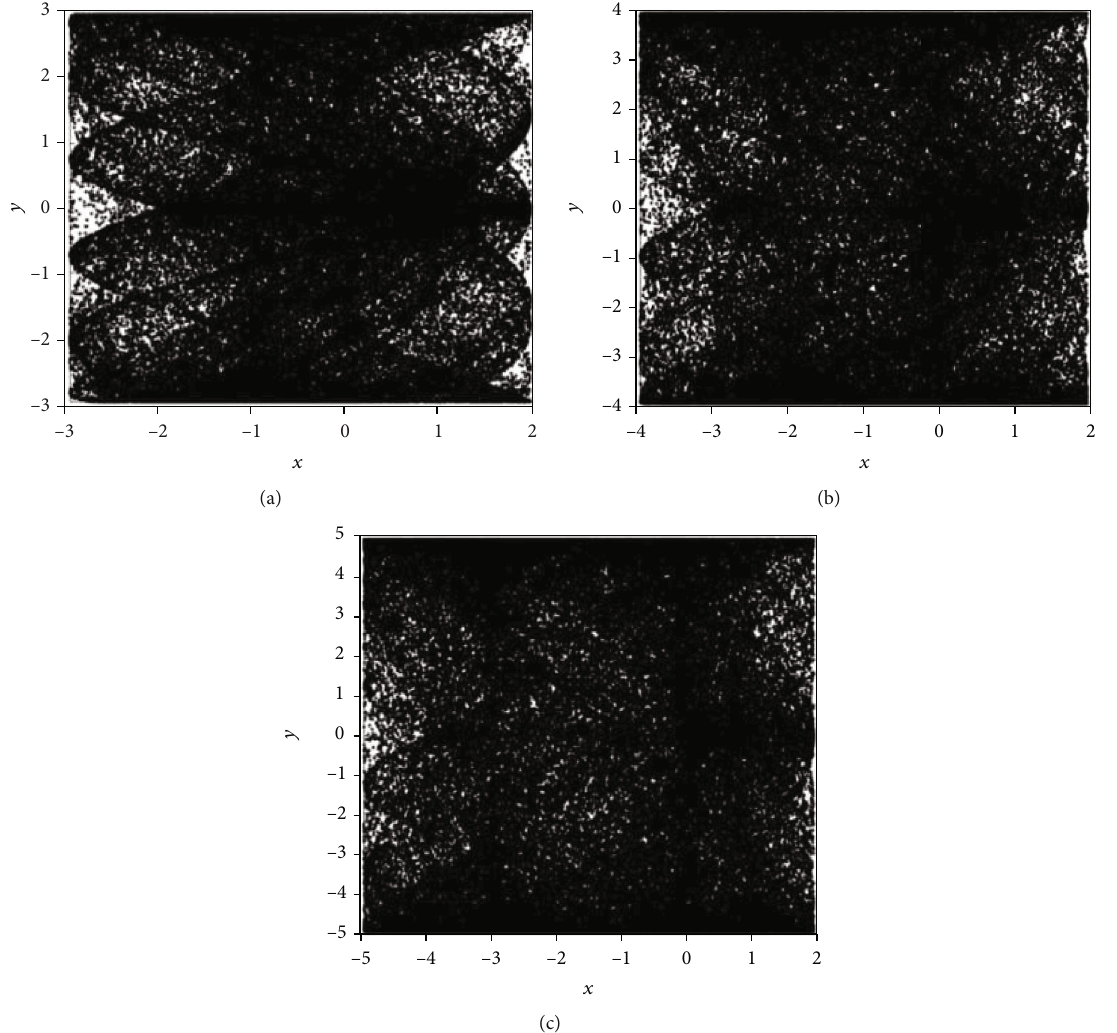
Figure 1: 2D-SCH trajectory of di ff erent parameters. (a) Trajectory of μ = 3 . (b) Trajectory of μ = 4 . (c) Trajectory of μ = 5